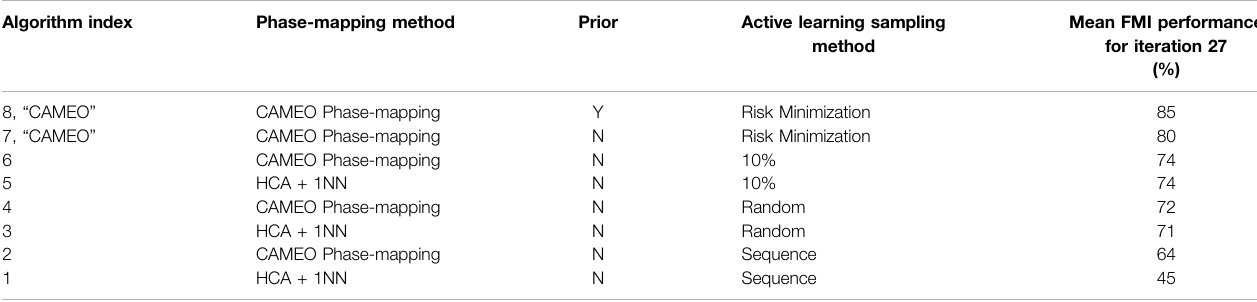
TABLE 2 | Phase-mapping methods in order of performance (descending) at iteration 27. Algorithm